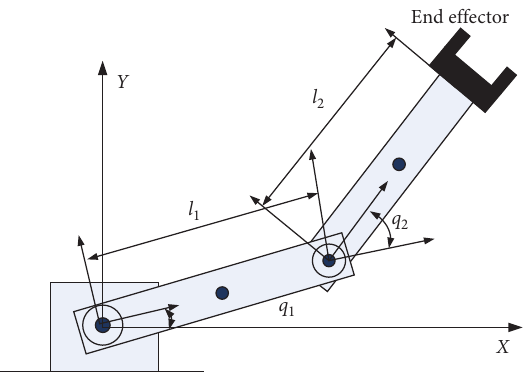
Figure 2: The schematic diagram of robotic manipulator with kinematics parameters. Table 1: The manipulator